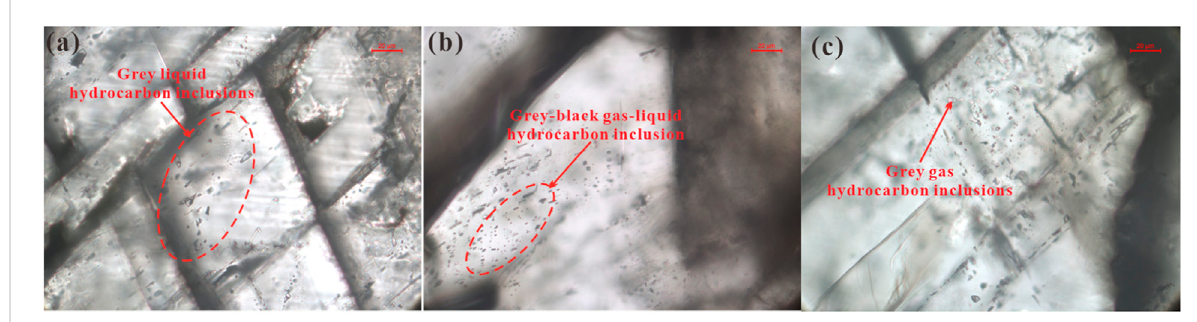
FIGURE 9 Photomicrographs demonstrating the fl uid inclusions ’ occurrence in the Dengying Formation (Well PT1) on the North Slope. (A) Grey hydrocarbon inclusions. Mono-phase (all-liquid) oil inclusions, triangular, elliptical, or elongated in shape, with a size of 2 – 6 μ m, are distributed in groups in dolomite; polarized light. (B) Two-phase gas-liquid aqueous fl uid inclusions with a gas-liquid ratio of less than 5%. Fluid inclusions are distributed primarily in groups in dolomite; polarized light. (C) Grey gas inclusions, mono-phase all-gas, with a size of 2 – 10 μ m, mainly distributed in groups in quartz; polarized